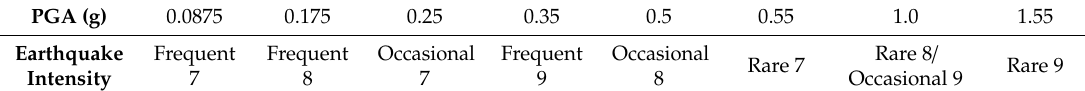
Table 7. PGA of earthquake intensity for the test.